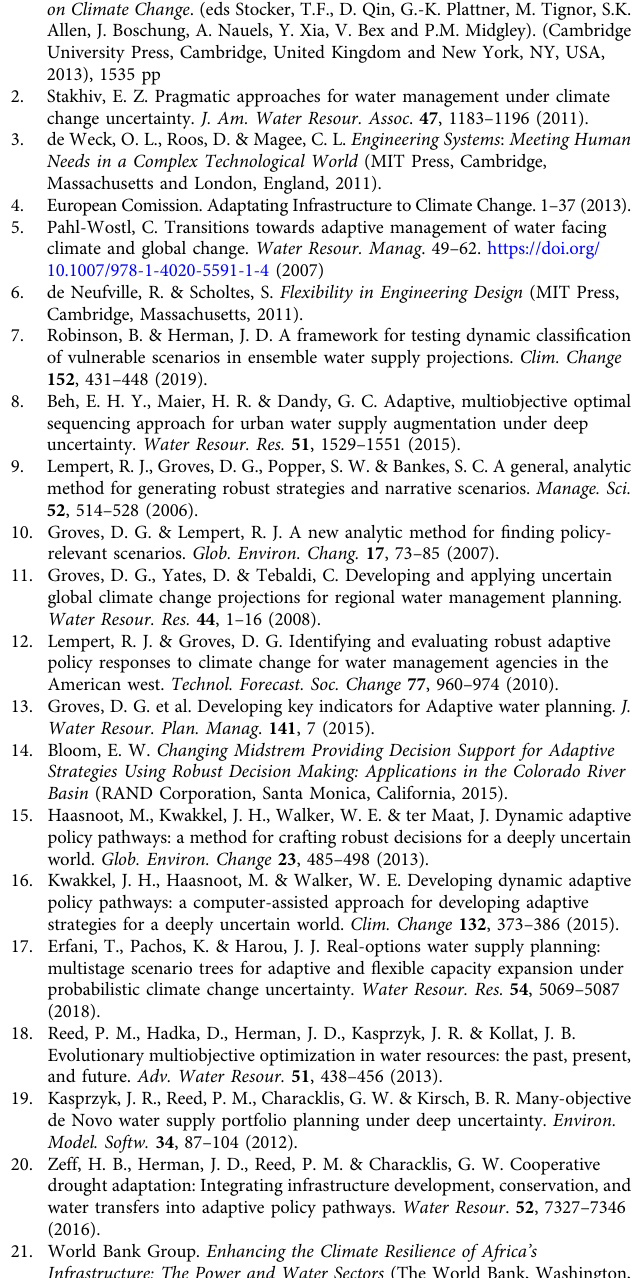
Supplementary Table 1. Stream fl ow data is available in Supplementary Data 1. Code